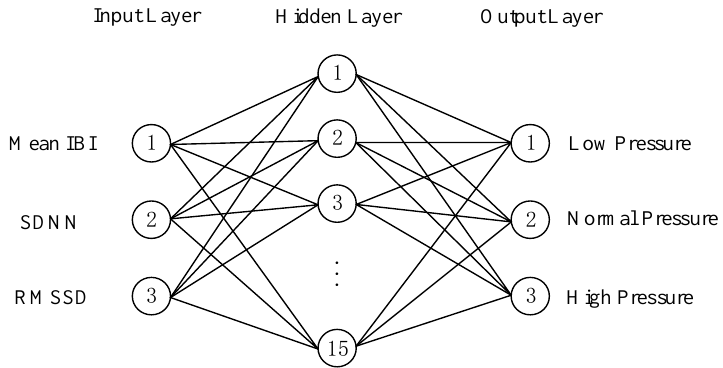
Figure 7. Three-layer ANN model structure.